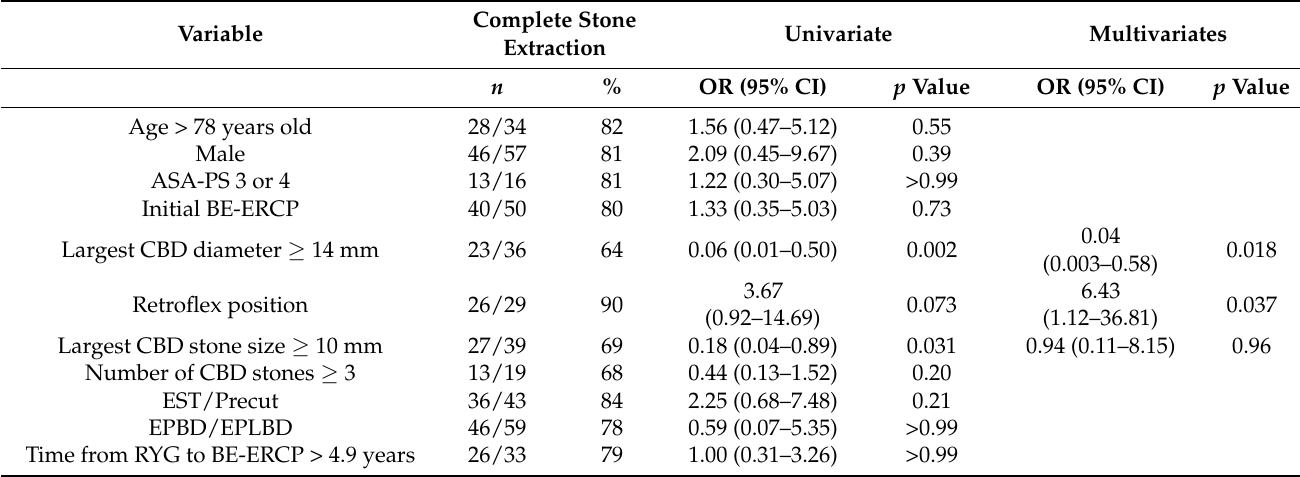
Table 4. Potential factors affecting complete stone extraction ( n = 66, overall).